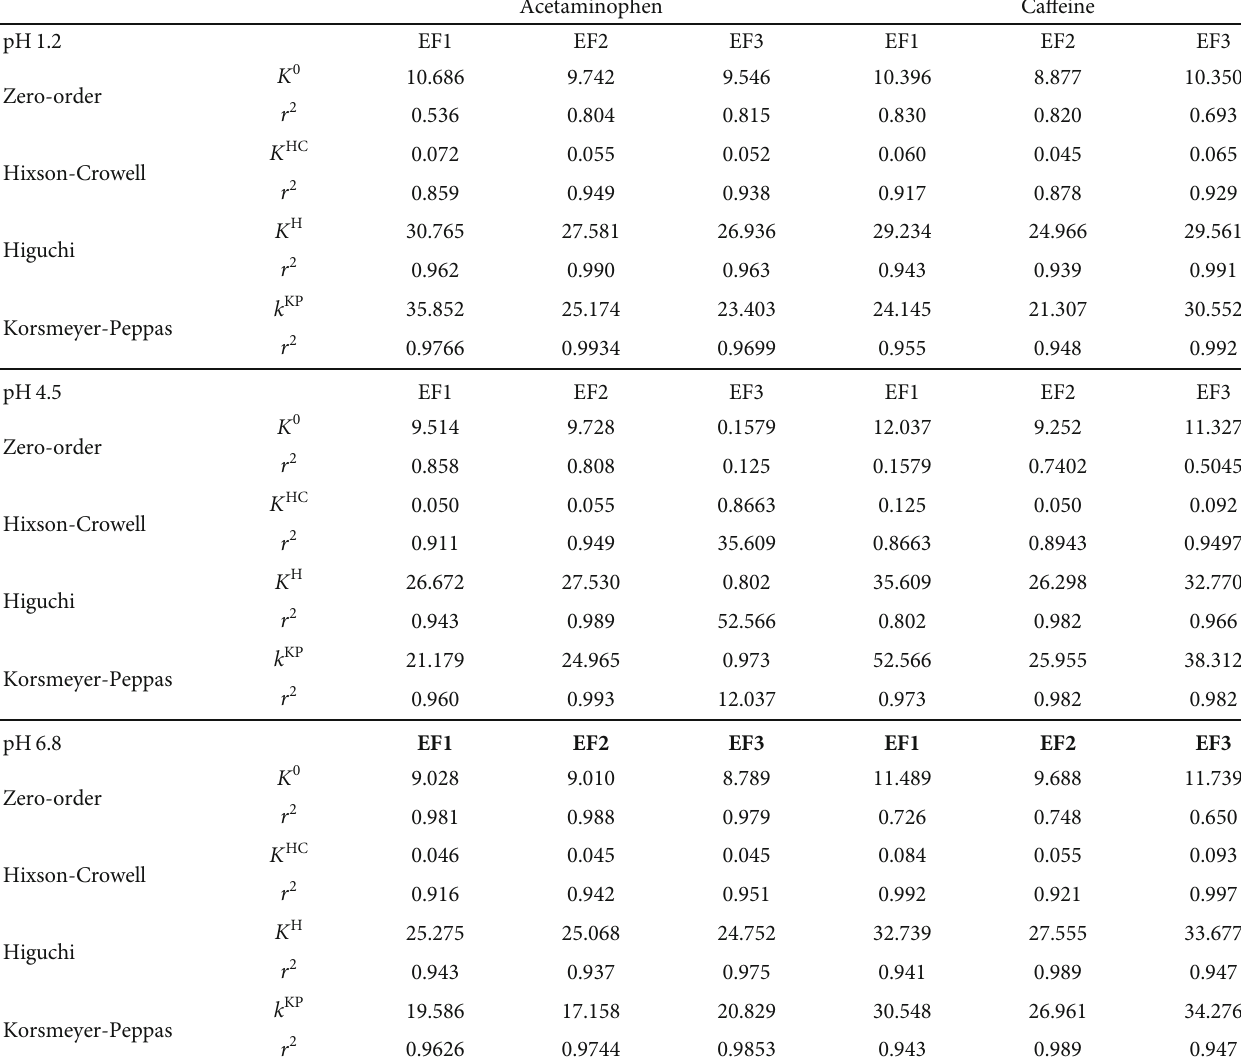
Table 4: Release kinetics of acetaminophen and ca ff eine from formulation EF1-EF3.